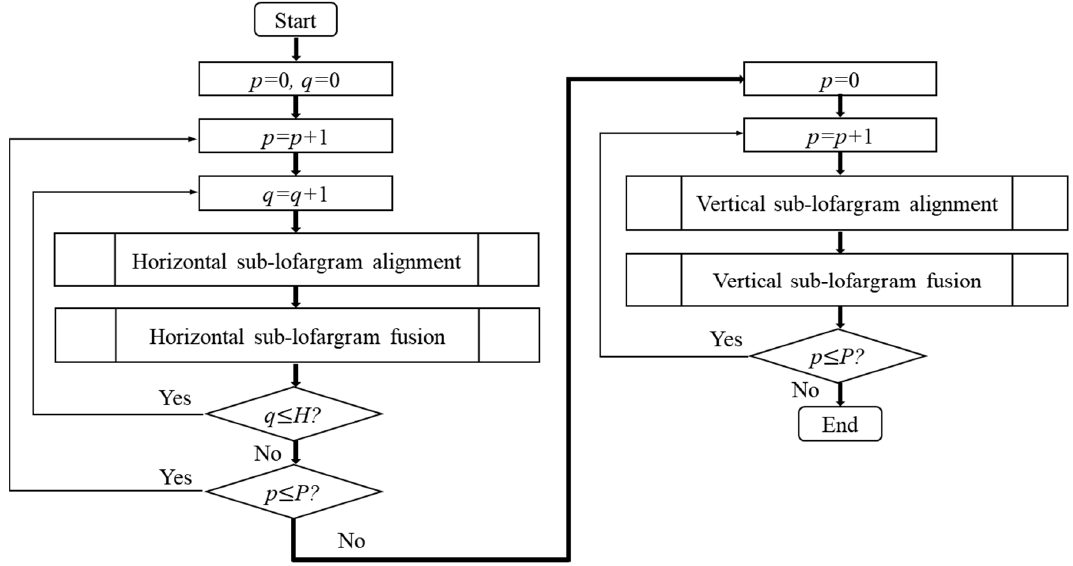
Figure 7. Merging overlapping frequency lines in different sub-lofargram.